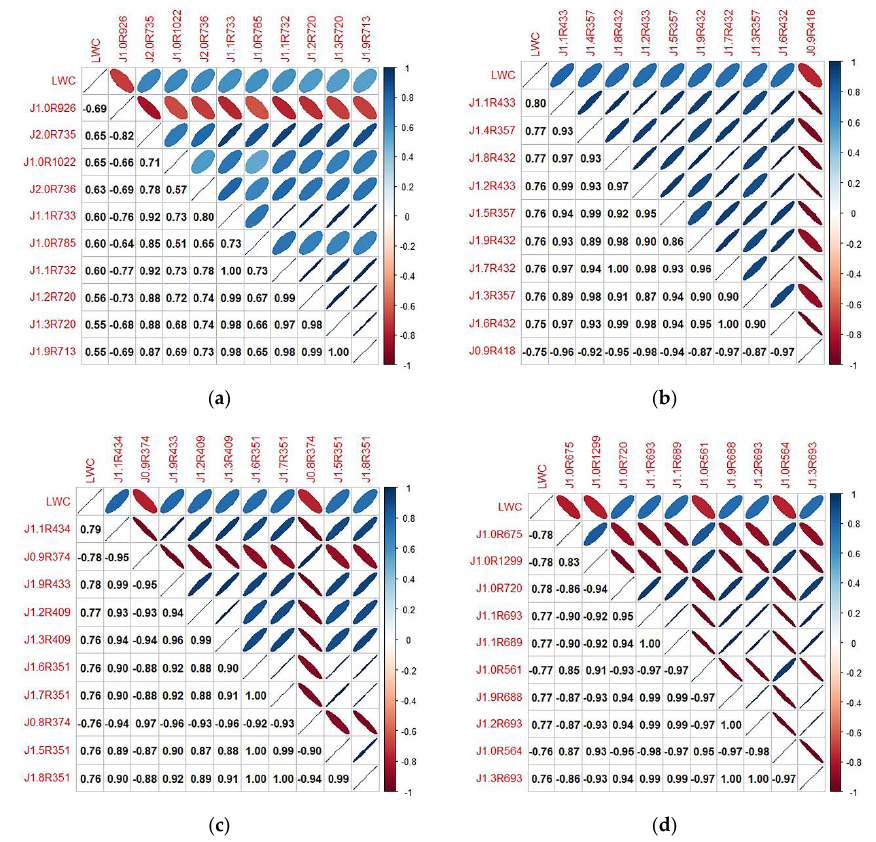
Figure 4. The relevance matrix of the selected fractional order differential spectra with LWC in four growth periods. ( a ) Jointing period; ( b ) booting period; ( c ) flowering period; ( d ) filling period.